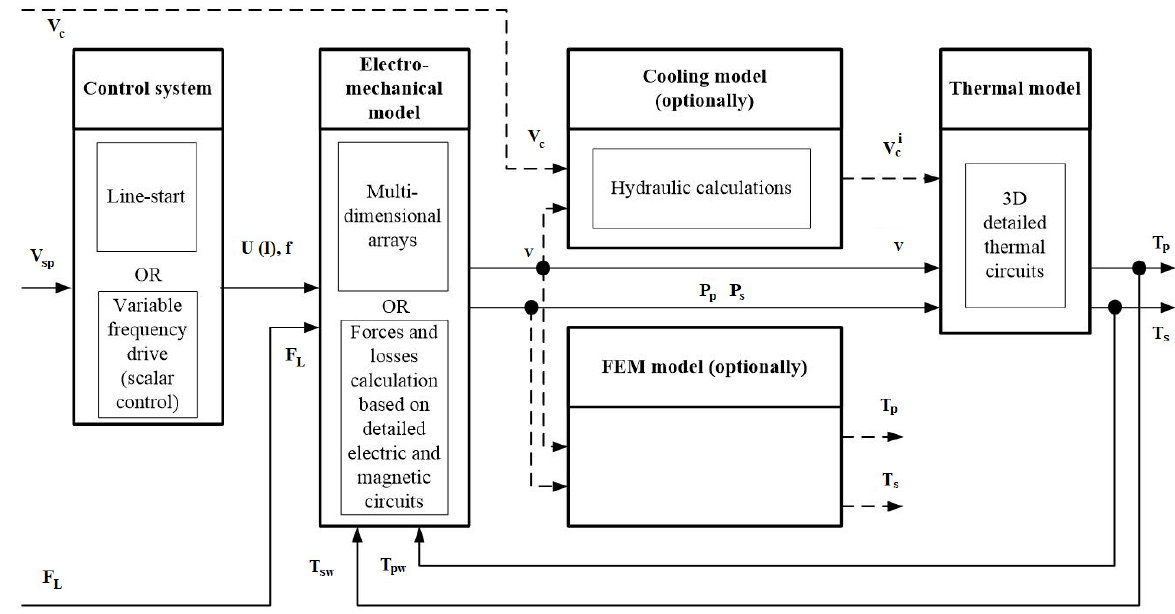
Figure 3. Submodels interconnection scheme.